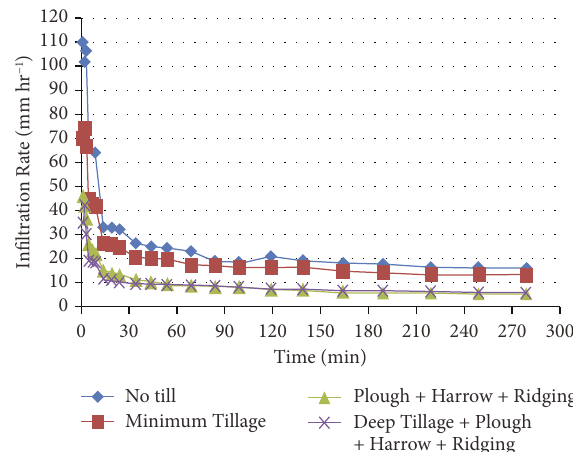
Figure 2: Effect of tillage methods on infiltration